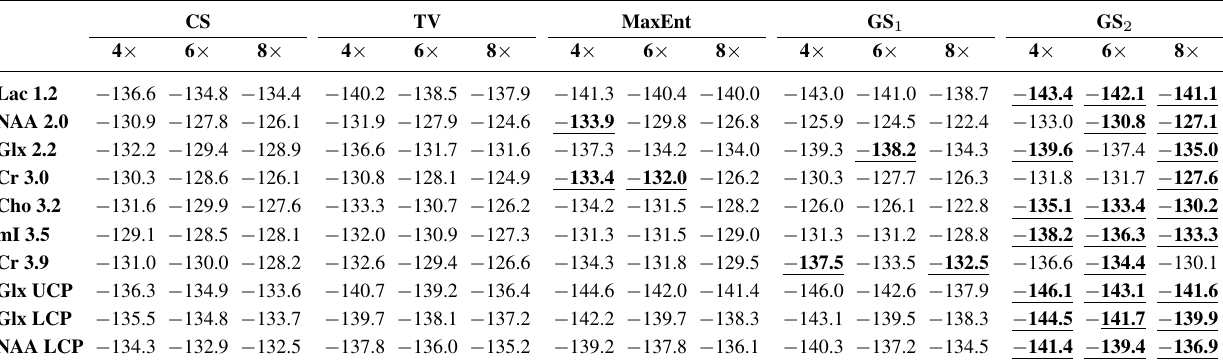
Table 3. Mean metabolite peak RMSEs (dB) for the 4 × , 6 × , and 8 × NUS reconstructions calculated over the 4 × 4 VOI of the in vivo 4D EP-COSI brain scan shown in Figures 4 and 5. The lowest RMSE for each metabolite peak and NUS rate is highlighted.